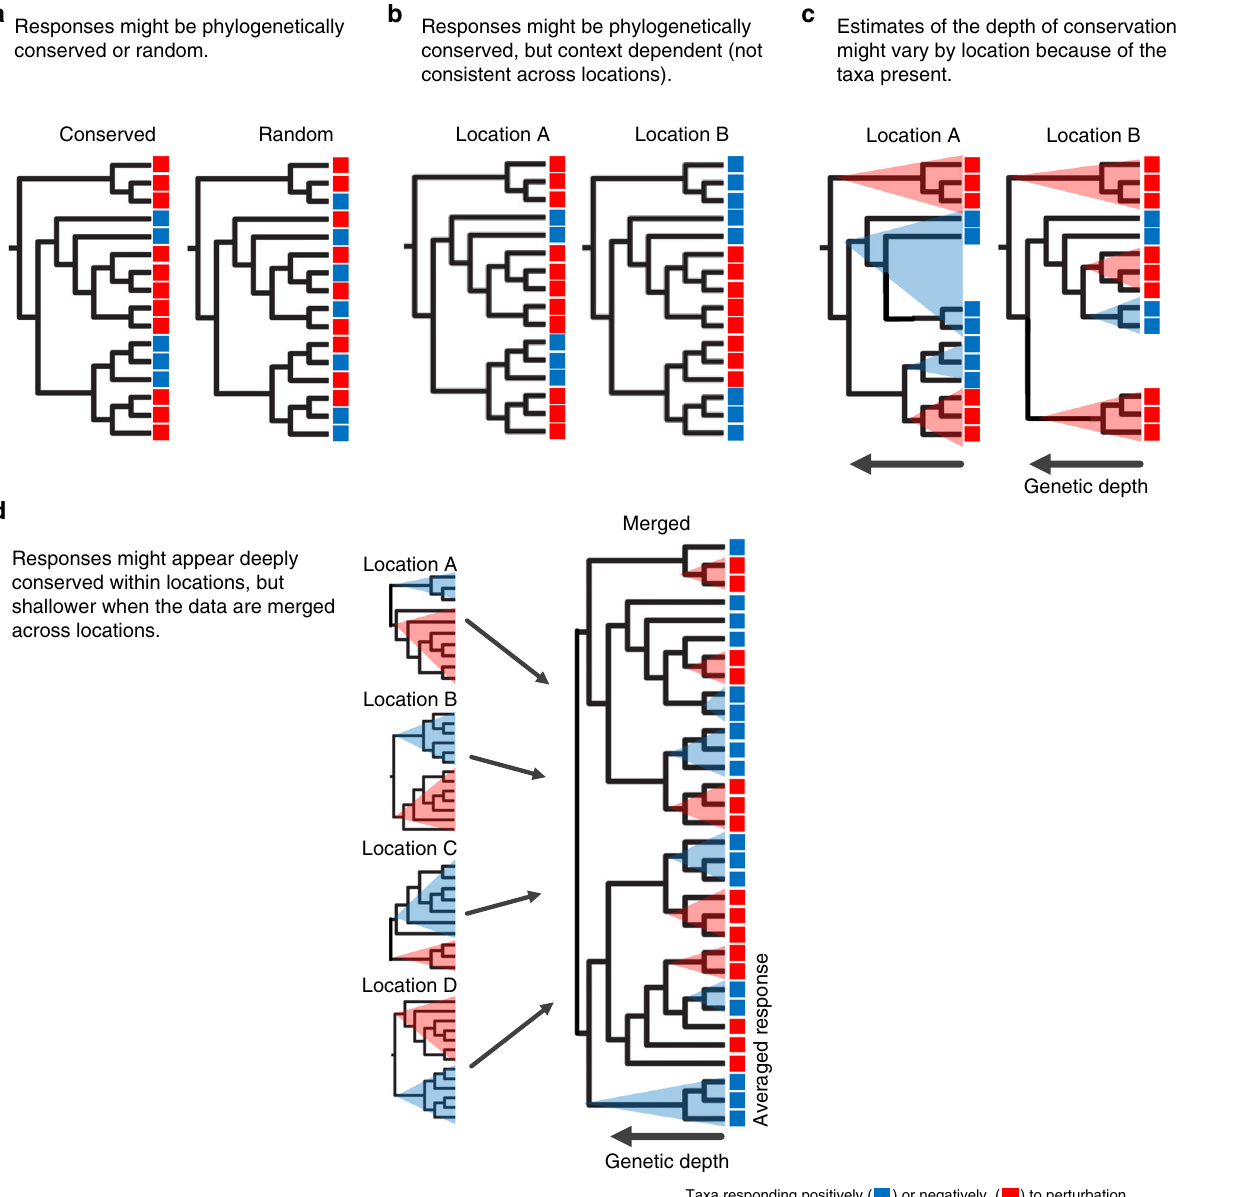
Fig. 1 The conceptual framework for the study. Bacterial taxa respond either positively (blue) or negatively (red) to an environmental perturbation. a The responses might be phylogenetically conserved (left) or random (right). b The responses might be phylogenetically conserved at each location, but context dependent. In this illustration, the response of nine taxa in location A differ in location B. c The response of individual taxa might be consistent across locations (not be context dependent), but estimates of the depth of conservation might vary because of the other taxa present. Here, a positively responding (blue) clade appears very deeply conserved in location A, but is broken up into shallower clades in location B. d To test the context dependency of responses to a perturbation and to identify clades that respond consistently across locations, one can compare the responses at individual locations (left) to those observed when datasets are merged across locations